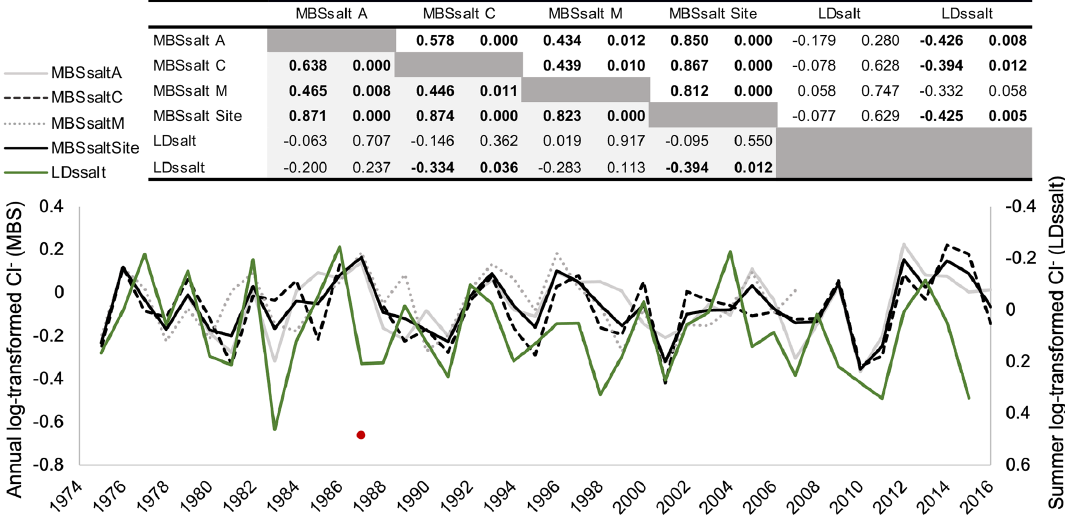
Figure 5. Time series of log-transformed annual sea salt concentrations for the Mount Brown South site average (MBSsaltSite), the Alpha (MBSsaltA), Charlie (MBSsaltC), and Main (MBSsaltM) ice cores, including the Charlie 1987 (red dot) outlier, and the log-transformed summer sea salt concentrations for the Law Dome (Dome Summit South site; LDssalt) record (on inverted secondary axis). The embedded table shows Pearson’s correlation coefficient ( r : left column; p : right column) for the log-transformed sea salt concentrations for MBSsaltSite, MBSsaltA, MBSsaltC, MBSsaltM, LDssalt, and the log-transformed annual sea salt concentrations for the Law Dome (LDsalt) record. Correlations for normalized Gaussian-smoothed (kernel = 3 yearly points; σ = 0.6) sea salt concentrations are shaded and presented in the lower-left of the table. Correlations significant at 95% are bold, and the dates range between 1975 and